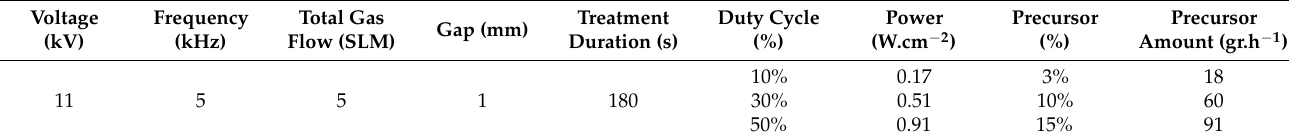
Table 1. Plasma experimental